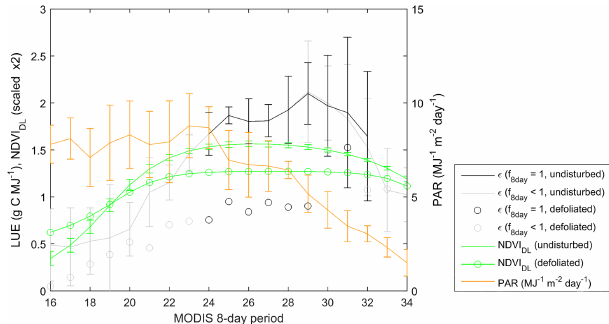
Figure 6. Light use efficiency ( ε ), NDVI fitted with double logistic functions (NDVI DL ) scaled × 2 (green), and PAR (orange) for the 6 years with data from the EC tower. Black lines with error bars and black circles are the light use efficiency values included when ε max and ε max , def were computed for undisturbed and defoliated years, respectively. The error bars are symmetric and 1 standard deviation higher or lower than the mean values.